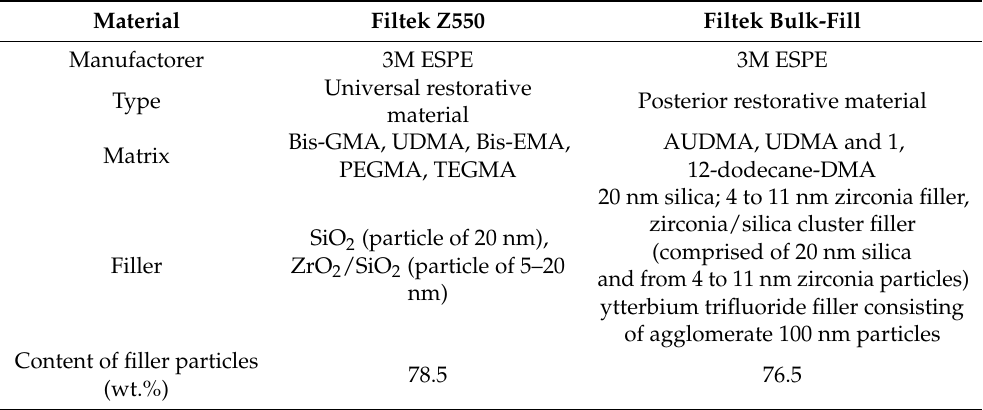
Table 1. PMCCs (Polymer Matrix Ceramic Composites) used in this study and their composition and percentage fraction (weight [wt.%]) of inorganic fillers [33,34]. Material Filtek Z550 Filtek Bulk-Fill Manufactorer 3M ESPE 3M ESPE Universal restorative Posterior restorative material Type material Bis-GMA, UDMA, Bis-EMA, AUDMA, UDMA and Matrix PEGMA, TEGMA